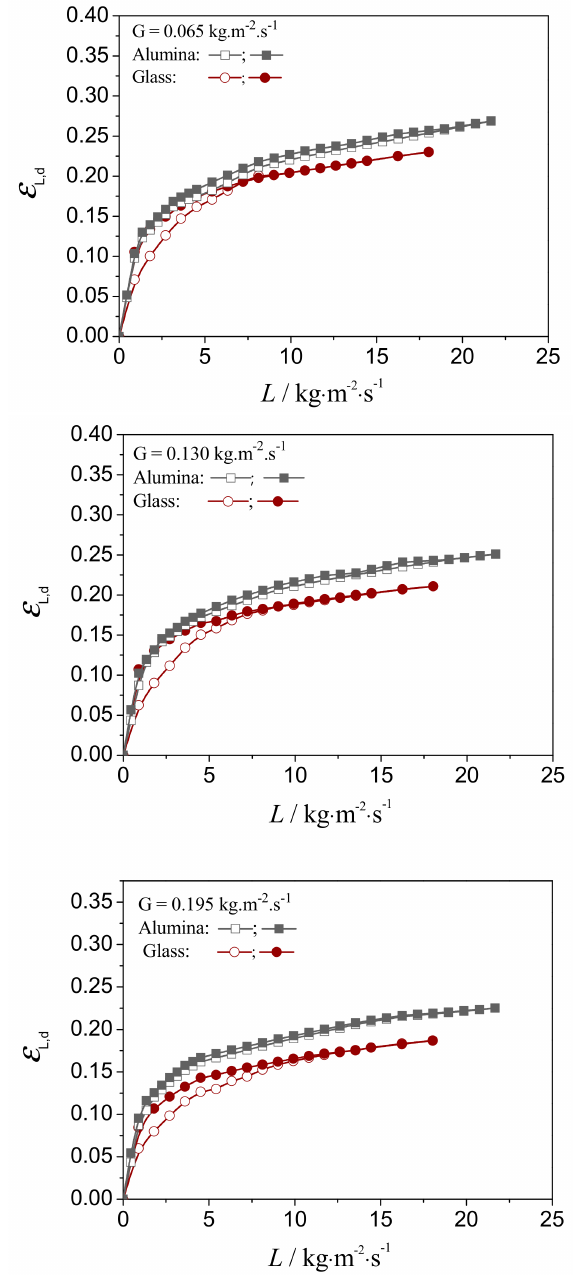
Figure 2. Dynamic liquid holdup measurements for different pellet